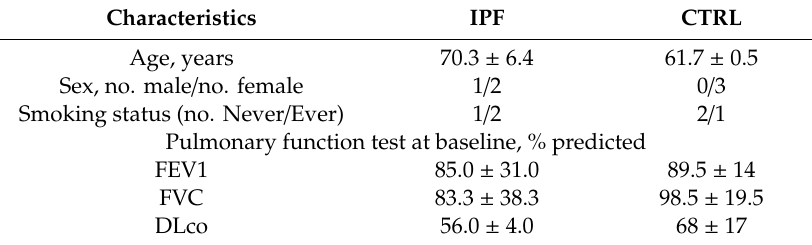
Table 2. Demographical and functional characteristics of IPF cases and controls.